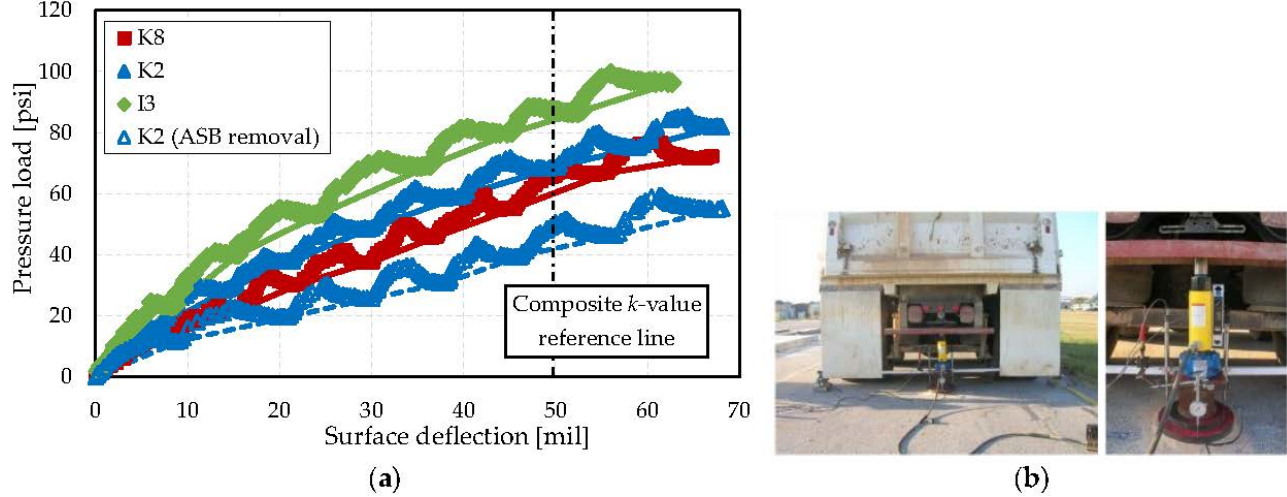
Figure 3. ( a ) Results of the non-repetitive plate load test, and ( b ) overview of the field set-up (1 psi = 6.89 kPa, 1 mil = 2.54 × 10 − 2 mm). Table 3. Composite k -value from non-repetitive static plate load test (1 psi/in = 271 kN/m 3 ).